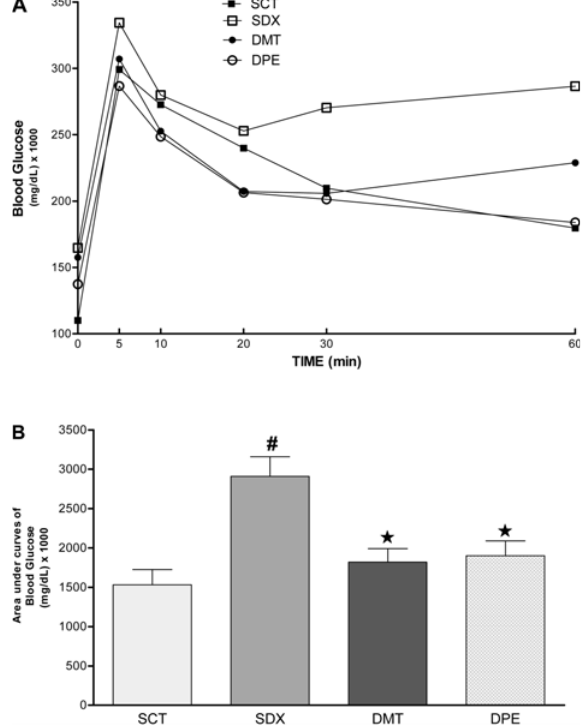
Figure 2. Glucose tolerance test (GTT) carried out in different groups of rats. SCT: Sedentary control group (n=8) treated with 0.9% NaCl solution ( sc , for 4 days) without swimming activity. SDX: Sedentary dexamethasone group (n=12) treated with 0.1 mg/kg dexamethasone (DEXA, sc, daily, for 4 days), without swimming activity. DPE: DEXA-treated physical exercise group (n=10) treated with 0.1 mg/kg DEXA ( sc, daily, for 4 days), with swimming activity (4 days, 1 h/day). DMT: DEXA and metformin (MET) treated group (n=12) treated with MET (300 mg (cid:1) kg – 1 (cid:1) day – 1 ; gavage, for 4 days), without swimming activity. A , Data are reported as means ± SE. B , Data are reported as the mean area under the curve ± SE for each group. # P o 0.001 compared with the SCT group. *P o 0.01 compared with the SDX group (ANOVA followed by Tukey ’ s